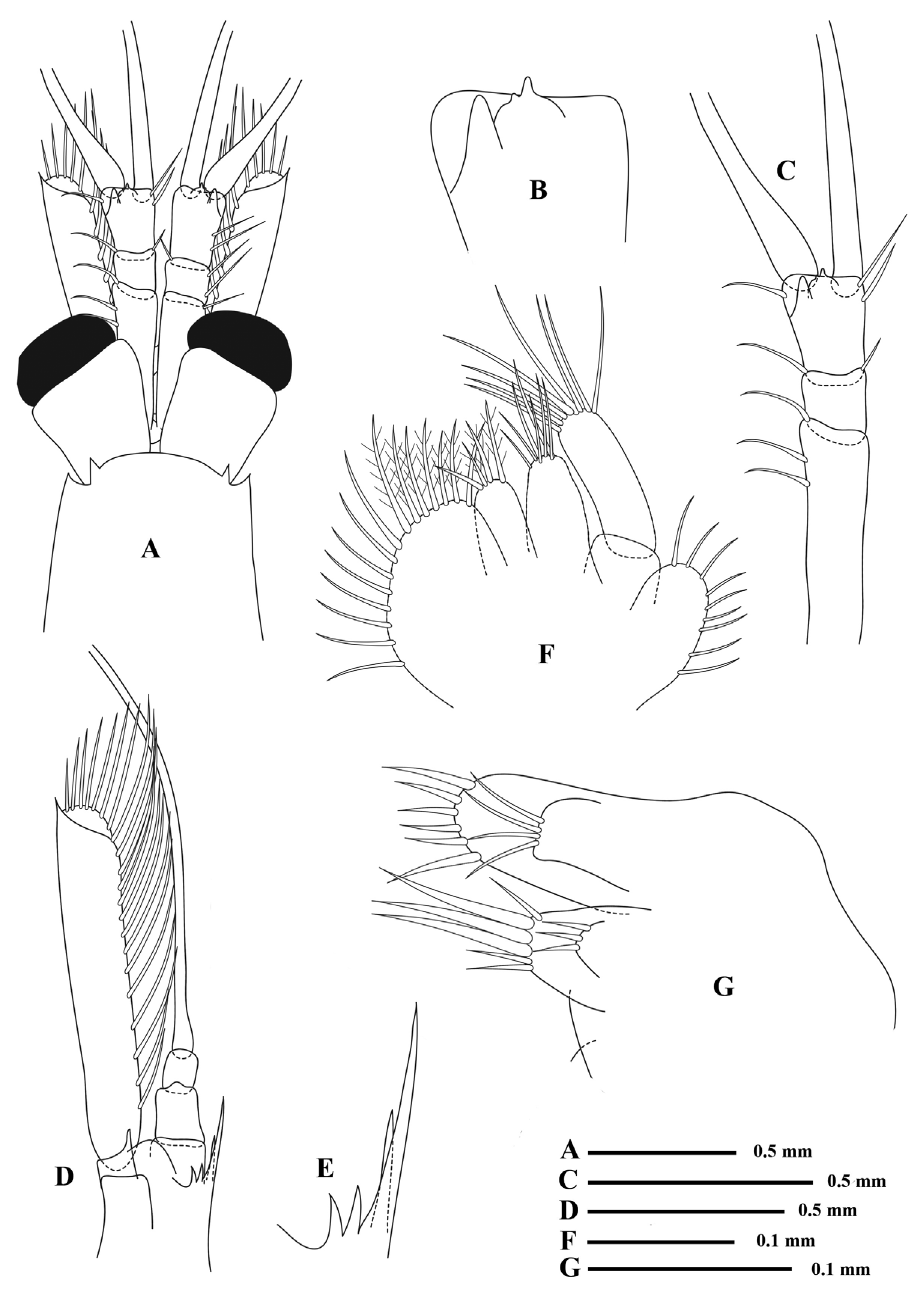
Figure 3. Rhopalophthalmus longipes ; A anterior part of carapace B third segment of antennular peduncle C antennule D antenna and antenna scale E sympod spines of antenna F maxilla G